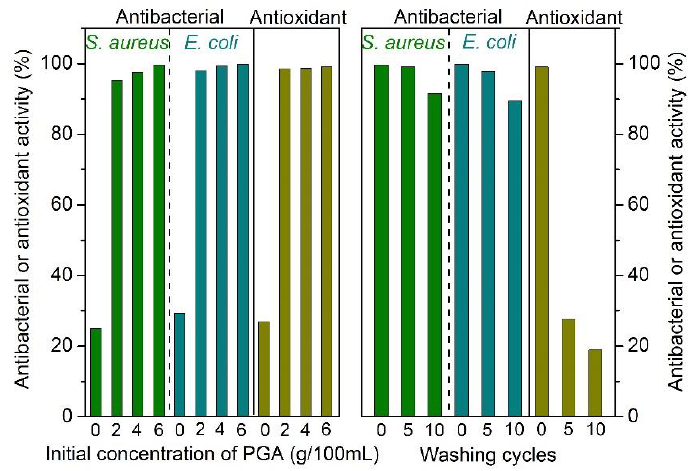
Figure 7. Antibacterial and antioxidant activity of the dyed silk fabrics and their washing durability for the dyed silk with the 6 g/100 mL PGA/Glc reaction products.